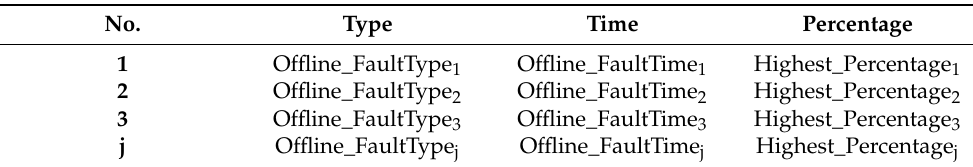
Table 12. Evaluation_List for a RealCase object.